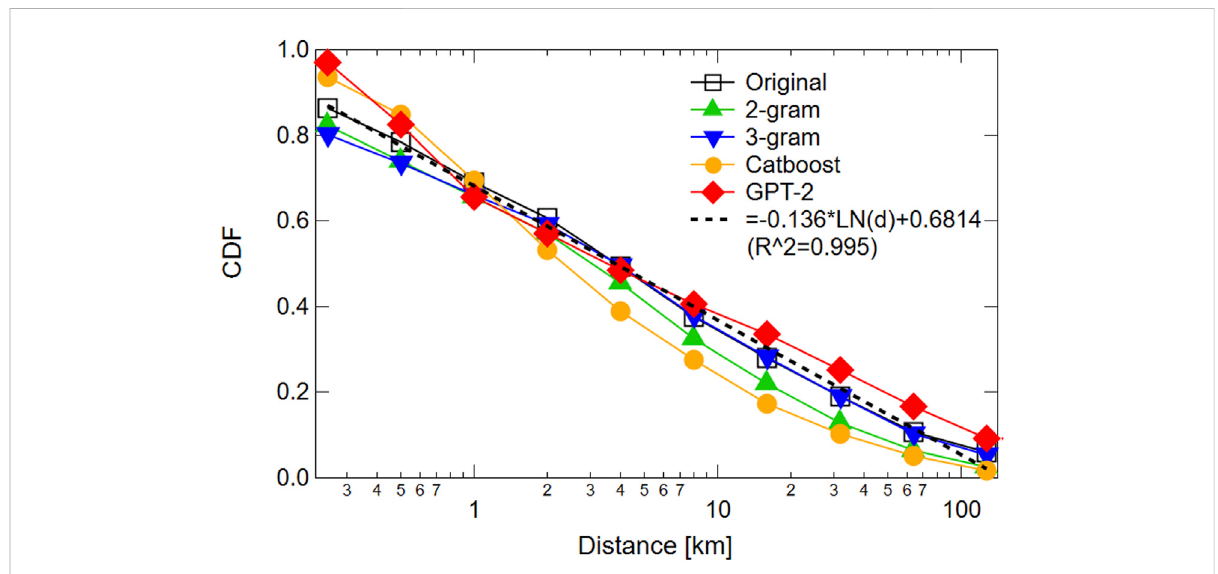
(cid:129) )Multi-Output